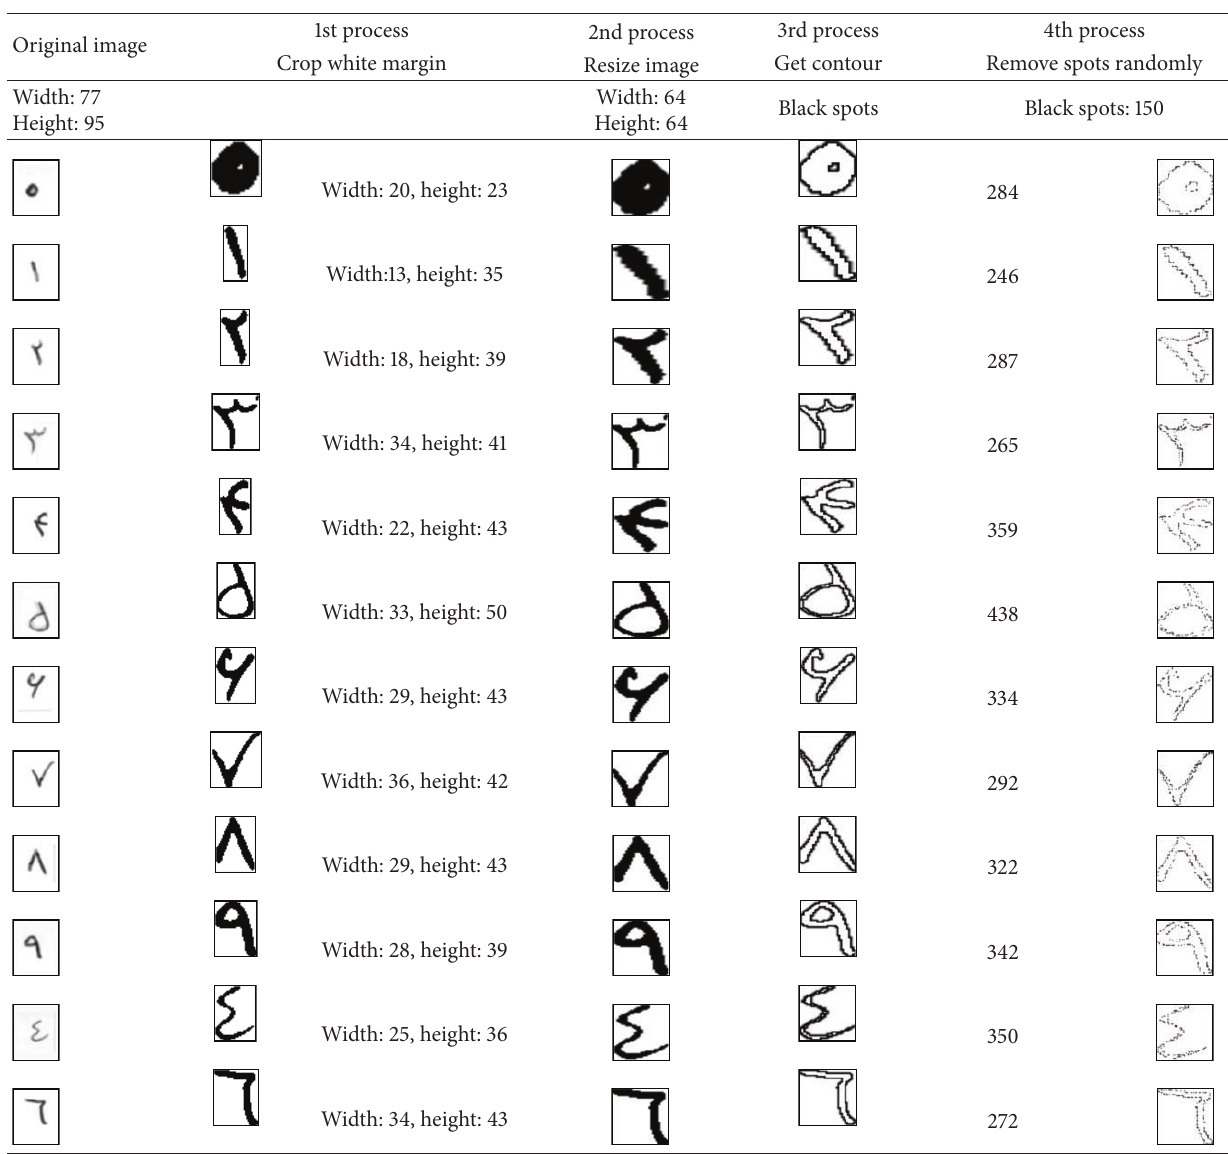
Table 5: Preprocessing of some test